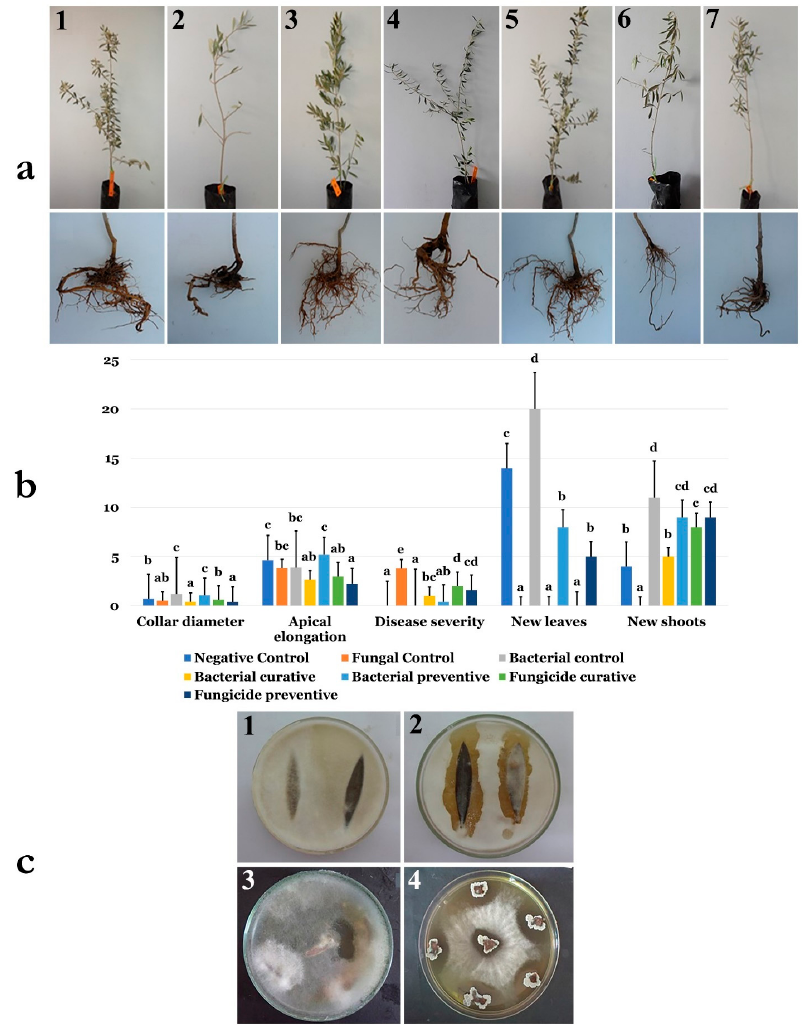
Figure 9. ( a ) Effect of preventive, concomitant, and curative biocontrol treatment on olive trees after 4 months post-inoculation with F. solani strain Fso1—representative non-treated (control) olive trees (1), infected with F. solani Fso1 (2), inoculated with B. velezensis OEE1 (3), infected with F. solani Fso1 and then treated with B. velezensis OEE1 (OEE1 curative treatment) (4), inoculated with B. velezensis OEE1 and then infected with F. solani Fso1 (OEE1 preventive treatment) (5), infected with F. solani Fso1 and then treated with the fungicide (fungicide curative treatment) (6) and inoculated with